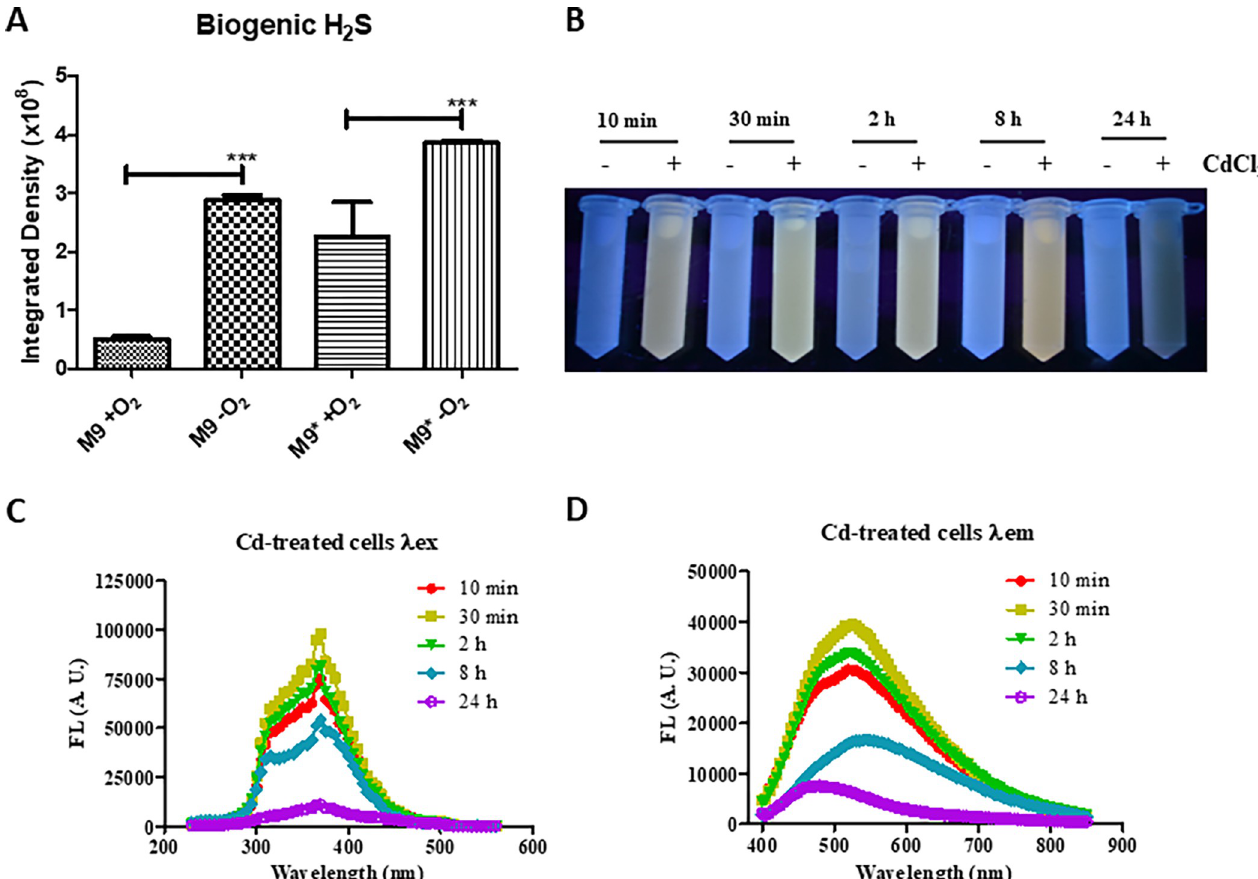
Fig 3. Release of H 2 S by MF05 in M9 or M9 � media, under aerobic or anaerobic conditions, and fluorescence tracing of CdS QDs formation at different times under anaerobic conditions. (A) Integrated density of image processing of H 2 S release by MF05 cells grown in M9 or M9 � medium under aerobic or anaerobic conditions with PbS filter papers. (B) CdS QDs formation after anaerobic growth of MF05 in M9 � medium treated with 864 μ M CdCl 2 with their respective negative controls. (C) Excitation and (D) emission spectra scan of Cd-treated MF05 cells. λ ex: excitation with 590 nm emission wavelength; λ em: emission with 370 nm excitation wavelength. For (A) the results represent the average of three independent trials ± SD ��� , P < 0.001.